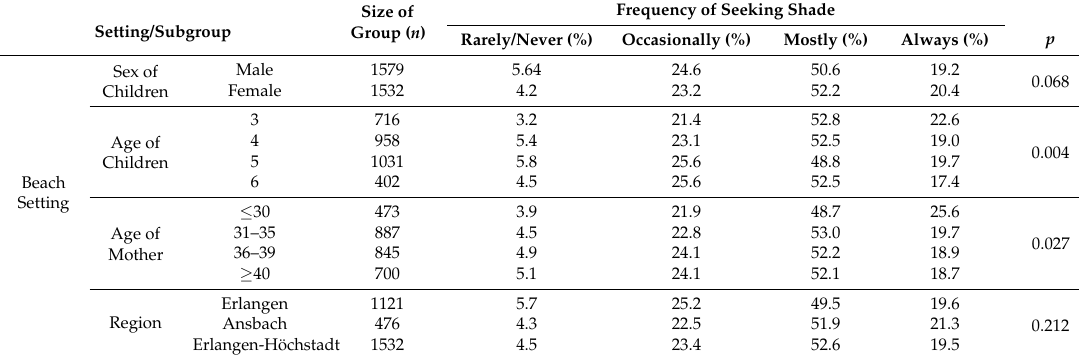
Table 2. Shade-seeking behavior in two outdoor settings (beach—upper part and garden—lower part) based on answers of 3129 parents of three- to six-year old children in the Erlking-II-study in three Bavarian districts in Southern